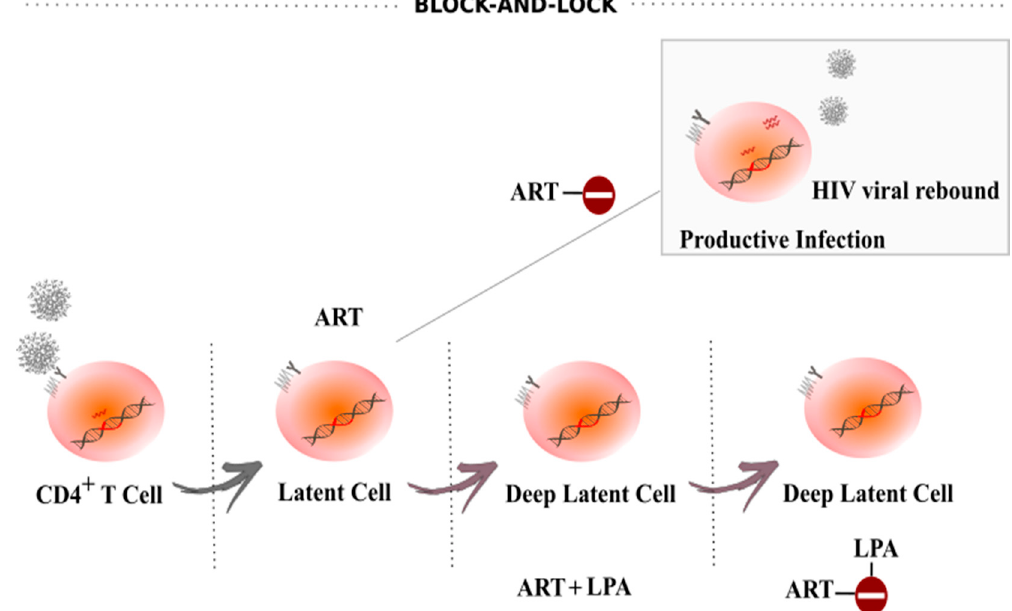
Figure 3. Block-and-lock approach as a functional cure for HIV-1 infection. The block-and-lock approach entails the long-term durable silencing of viral gene expression. Supplementation of ART with a latency promoting agent (LPA), such as the Tat inhibitor didehydro-Cortistatin A (dCA), could suppress ongoing transcriptional events, induce epigenetic silencing over time and promote a state of “deep latency”, blocking or limiting viral rebound upon treatment interruption.